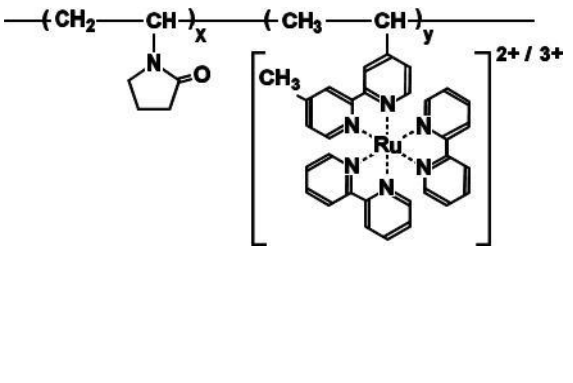
Figure 1. Chemical structure of poly(VP- co -Ru(bpy)